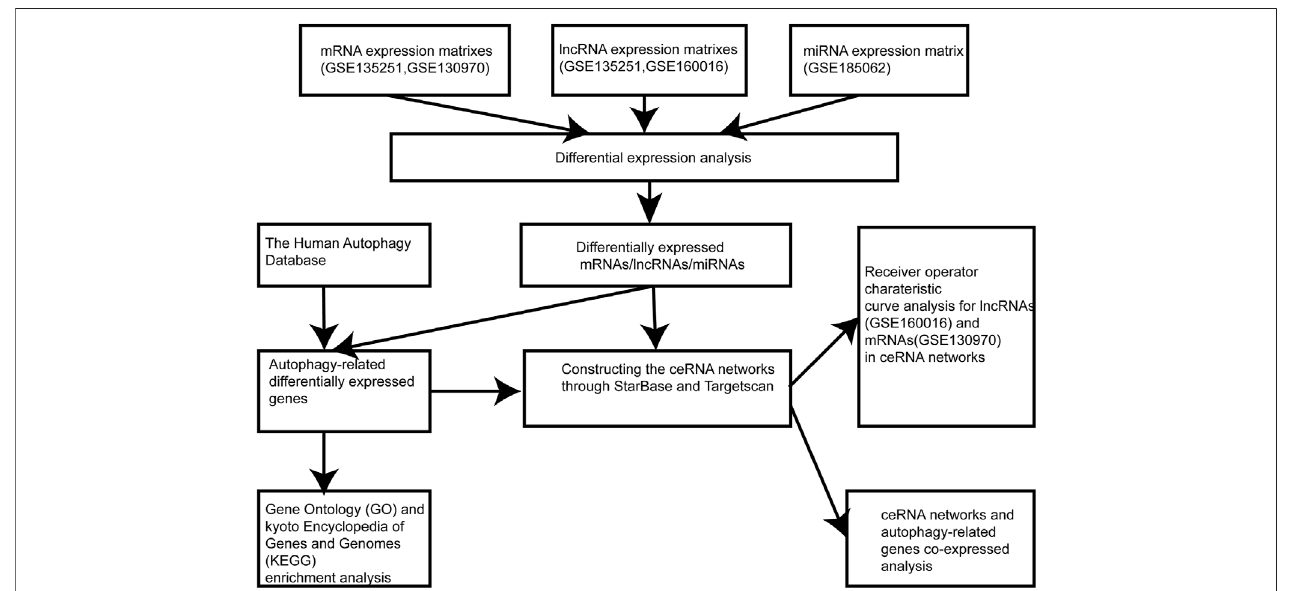
FIGURE 1 | Flowchart of the research design. lncRNA, long noncoding RNA; miRNA, microRNA.